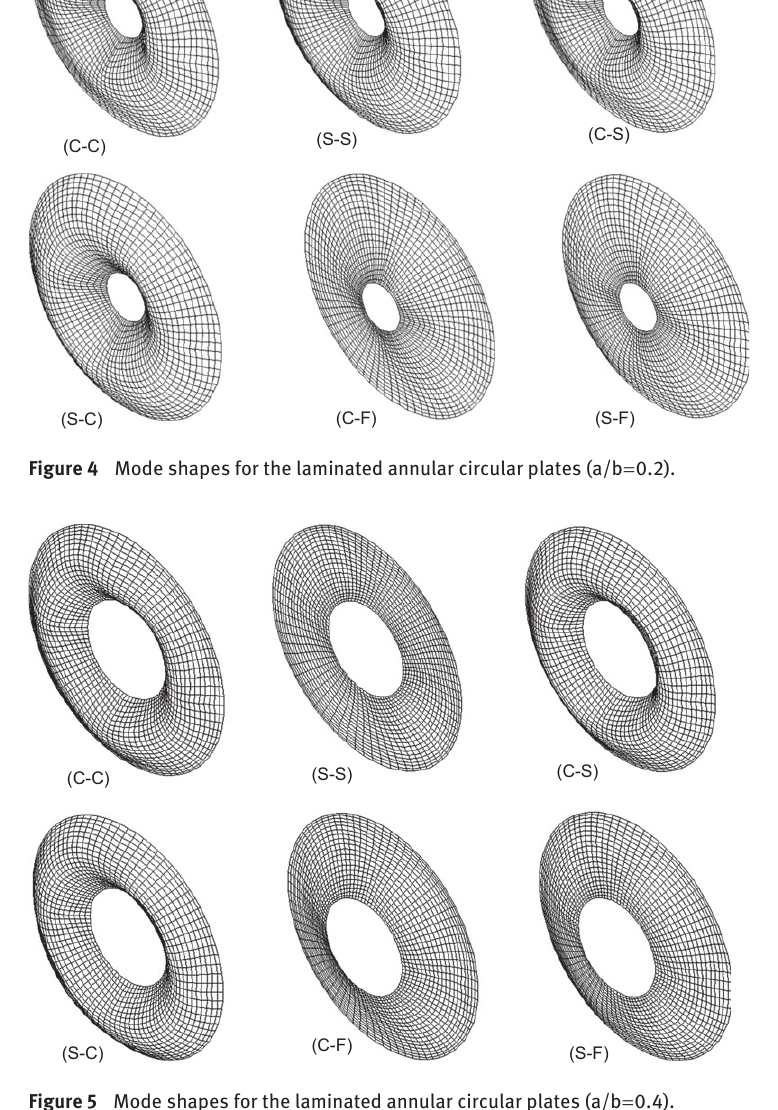
Figure 5 Mode shapes for the laminated annular circular plates (a/b =